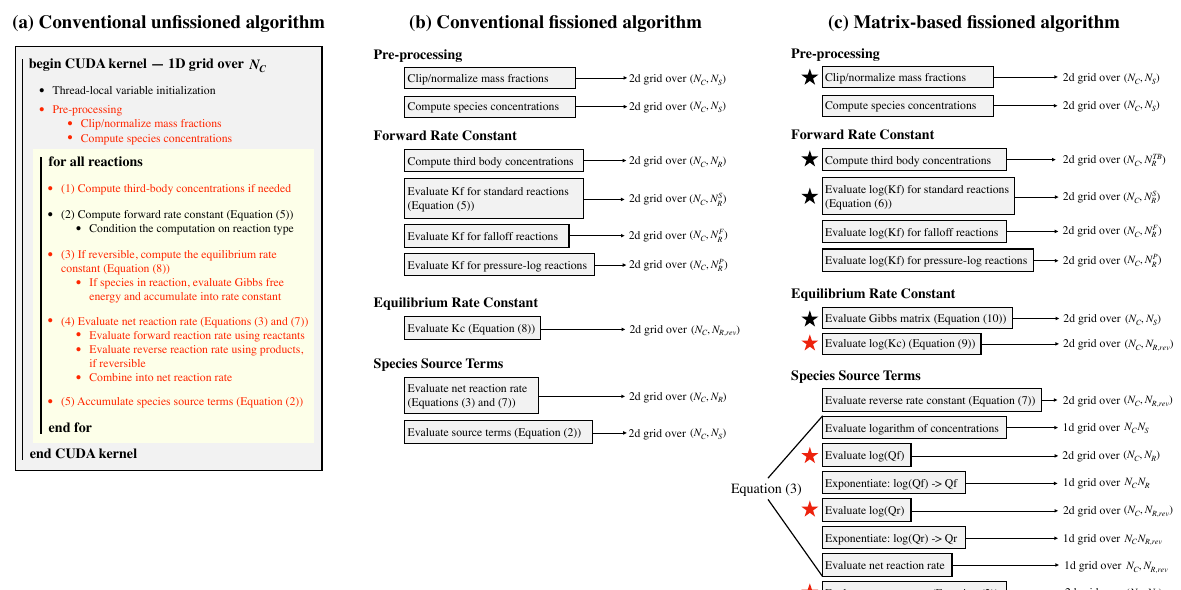
Figure A3. ( a ) The conventional unfissioned algorithm. The gray box denotes the scope of the CUDA kernel. The notation “1D grid over N C ” means the kernel is launched on a one-dimensional grid of thread blocks defined by the number of cells N C . The yellow box denotes the per-thread reaction loop. The steps marked in red denote locations where a loop over the number of species N S is required (arithmetic in a species loop is only performed for a species involved in the given reaction). ( b ) The conventional fissioned algorithm to be read top-down. Each gray box denotes a single kernel launch. For each kernel, the arrow indicates the dimensionality of the kernel launch (i.e., vectorization directions). ( c ) Same as ( b ), but instead shows the matrix-based fissioned algorithm as profiled in Section 3.1 (the primary contribution of this work). Black stars denote kernels that can be evaluated using cuBLAS and red stars denote kernels that allow for cuSPARSE calls if desired (see Section 3.4).